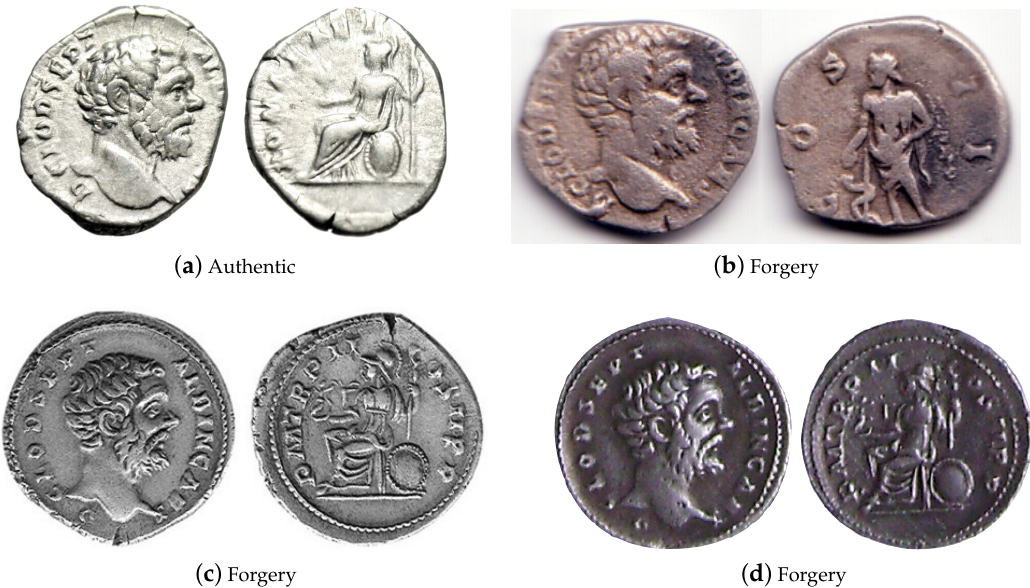
Figure 5. Example of ( a ) an authentic silver denarius of Clodius Albinus, and ( b – d ) three examples of forgeries (different issues of silver denarii, all with Clodius Albinus as the issuing authority). Though reasonably convincing at first sight, the forgery in ( b ) is in fact a cast (as witnessed by the sprue at 10–11 o’clock looking at the obverse, as well as the fine surface features). The forgery in ( c ) is poor in style and thus utterly unconvincing. The poor style (though less so than the previous example) and inappropriate metal composition, evident from the toning of the specimen, also make the forgery in ( d ) an unconvincing